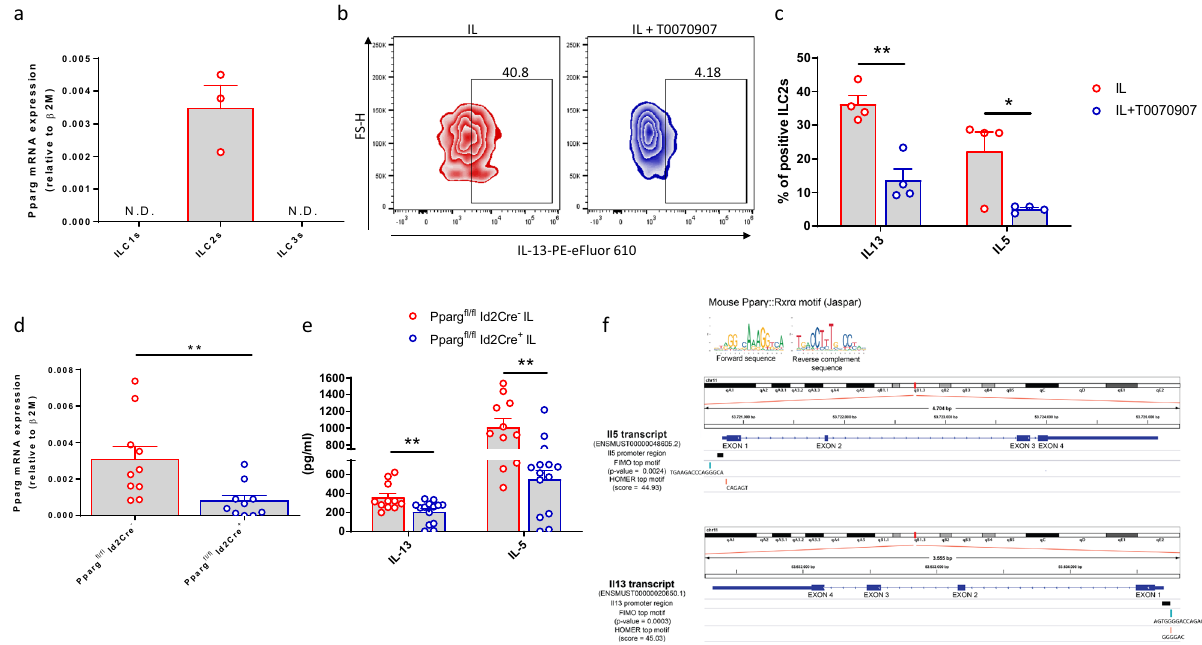
Fig. 6 PPAR γ is expressed and functional in mouse ILC2s. a Expression of Pparg assessed by qPCR analysis in freshly-sorted ILC subsets from the lung of C57BL6 mice ( n = 3). b Representative example of fl ow cytometry analysis of mouse ILC2-derived IL-13 upon T0070907 treatment in vitro. c Frequencies of IL-13 and IL-5 positive ILC2s untreated (open red circle) and after T0070907 treatment (open blue circle) ( n = 4; * P = 0.0101, ** P = 0.0015). d Expression of Pparg assessed by qPCR analysis in freshly-sorted ILC2s from the lung of IL-33/IL-25-treated Pparg fl / fl Id2 CreER T2 positive (open blue circle) or CreER T2 negative mice (open red circle) ( n = 10, ** P = 0.0098). e Quanti fi cation of IL-13 and IL-5 assessed by Legendplex analysis in cell culture supernatants of murine ILC2s upon stimulation with IL-33 and IL-25 in vitro ( Pparg fl / fl Id2 CreER T2 positive (open blue circle) or CreER T2 negative mice (open red circle)) ( Pparg fl / fl Id2 CreER T2 negative n = 11, Pparg fl / fl Id2 CreER T2 positive n = 14; IL-13 ** P = 0.0086, IL-5 ** P = 0.0035). f Location of motives similar to the PPAR γ -RXR α binding motif (top) in the promoter region of IL-5 and IL-13 (mouse genome). The motives with the lowest raw p-value found by the FIMO tool (blue) or the highest score found by the HOMER software (orange) are shown. The Integrative Genomics Viewer (IGV, v2.8.0) was used to represent the location of these motifs within the IL-5 and IL-13 promoters 84 . See Supplementary Data 2 for complete motif search results. Each symbol represents one individual mouse. Data are shown as mean ± SEM and were analyzed by Wilcoxon ( d ) or two-way ( c , e ) ANOVA tests. Source data are provided as a Source data fi